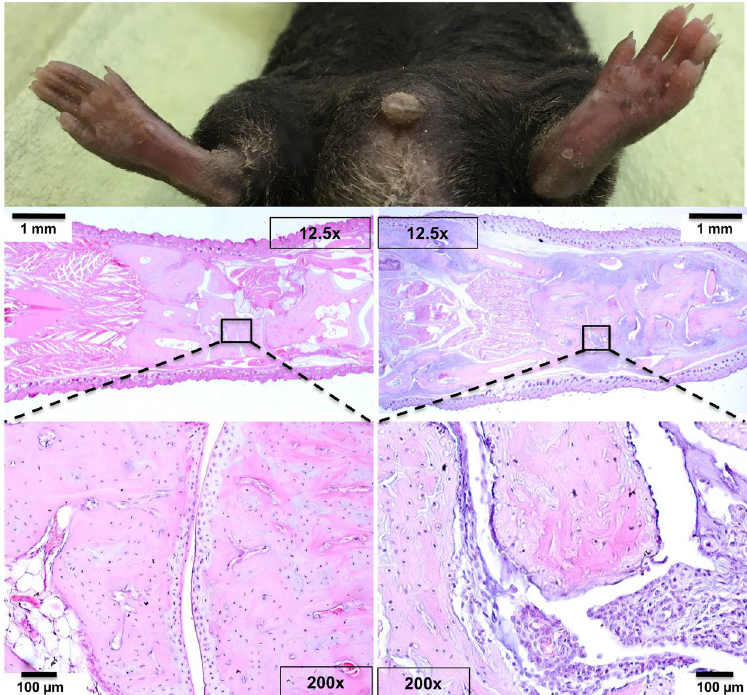
Figure 5. Macroscopic picture and HE-stained thin sections of non-inflamed (left panels) and inflamed (right panels) hind paws. The lower insert shows massive leukocyte infiltrations into the metatarsal joint spaces and illustrates the onset of articular cartilage destruction. 12,5x (middle) and 200x (lower)